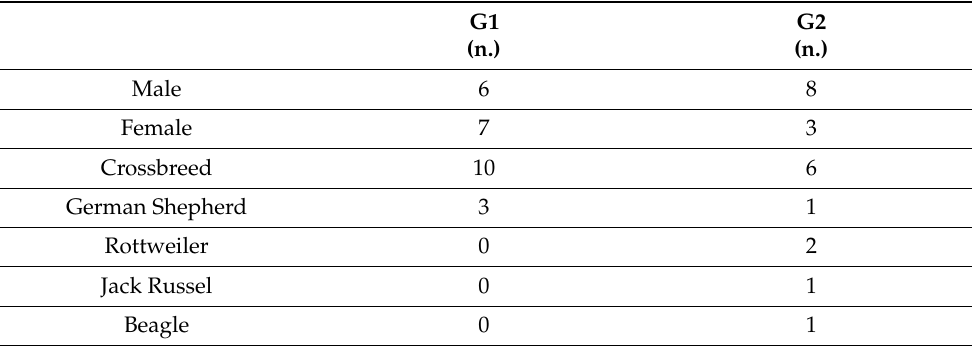
Table 2. Signalment of dogs included in G1 and